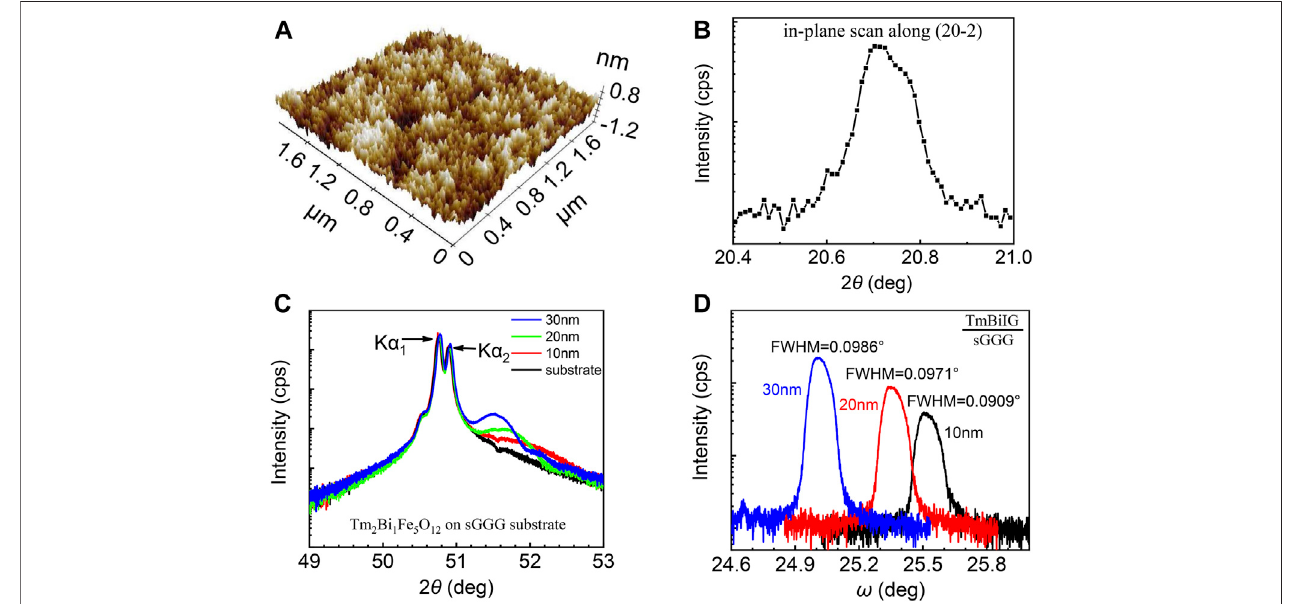
FIGURE1|(A) AFMsurfacemorphologyofa20-nm-thickTmBiIG fi lmina2 μ m×2 µmregionwithrmsroughnessof0.3 nm,demonstratingtheultra- fl atsurface. Crystallographic characterization results for the TmBiIG fi lms; (B) HRXRD in-plane scan of the 30-nm-thick sample along the (20-2) direction; (C) HRXRD ω – 2 θ scans of the (444) plane of the TmBiIG/sGGG (111), and (D) rocking curve of the TmBiIG (444) for various fi lm thicknesses.